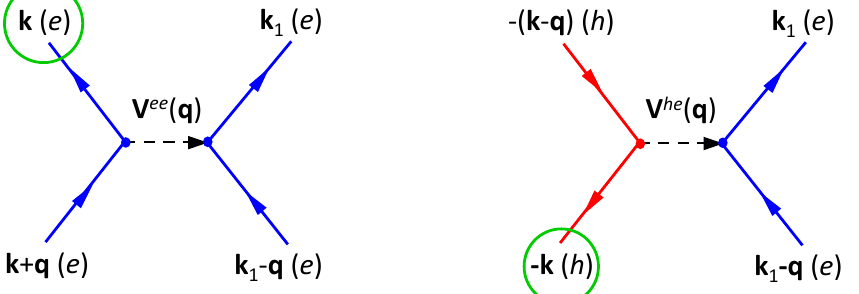
Figure 7. Feynman diagrams for CDD rate ∆ e ( k ) of electrons in Equation (34). ( left ) Coulomb coupling between pair of electrons in one inelastic-scattering event; ( right ) Coulomb coupling between an electron and a hole in another inelastic-scattering